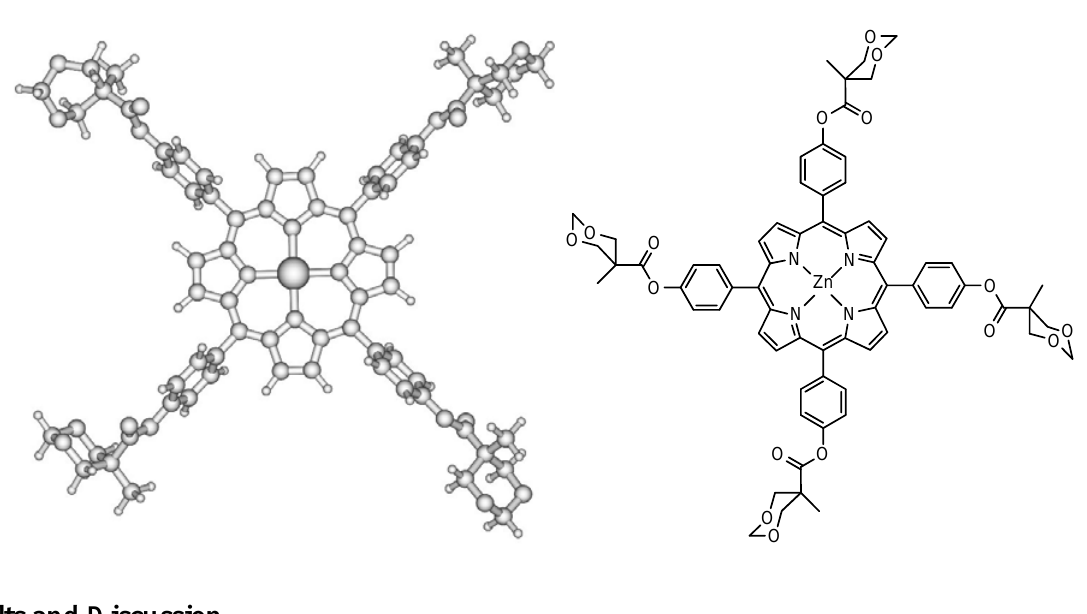
Figure 1. Model structure for the dendron substituted tetraphenyl Zn-porphyrin (TPPZn) molecule used in the